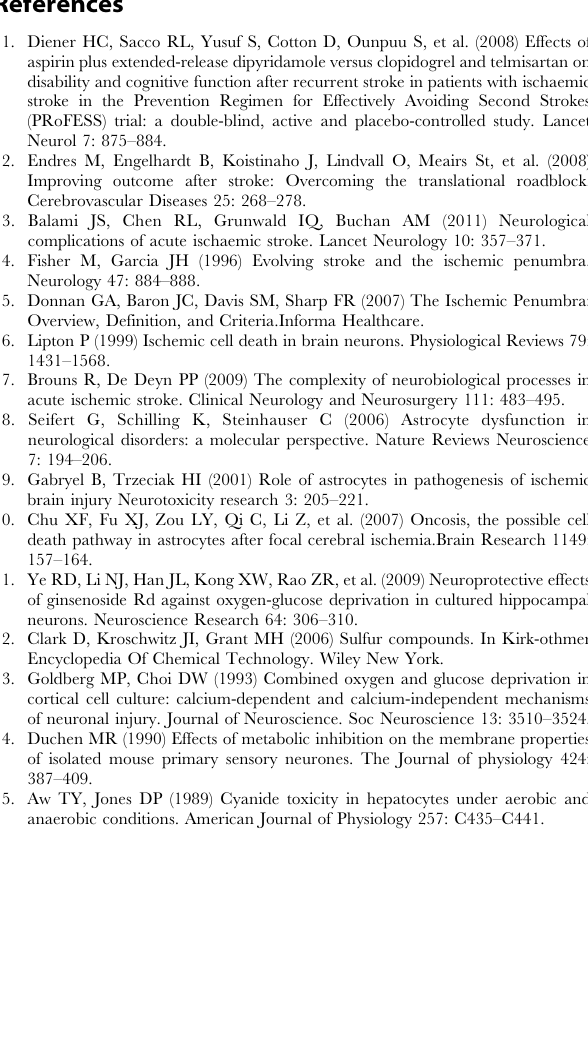
Figure S4 The LDH leakage between the mixed OGD and the physical OGD model. The LDH leakage of astrocytes exposed to mixed and the physical OGD model in the control condition (Ctrl) and for 1 h, 2 h, 3 h, 4 h and 6 h. Data are expressed as the mean 6 SD; (*) indicates a significant difference (P , 0.05) between the mixed group and the physical group.